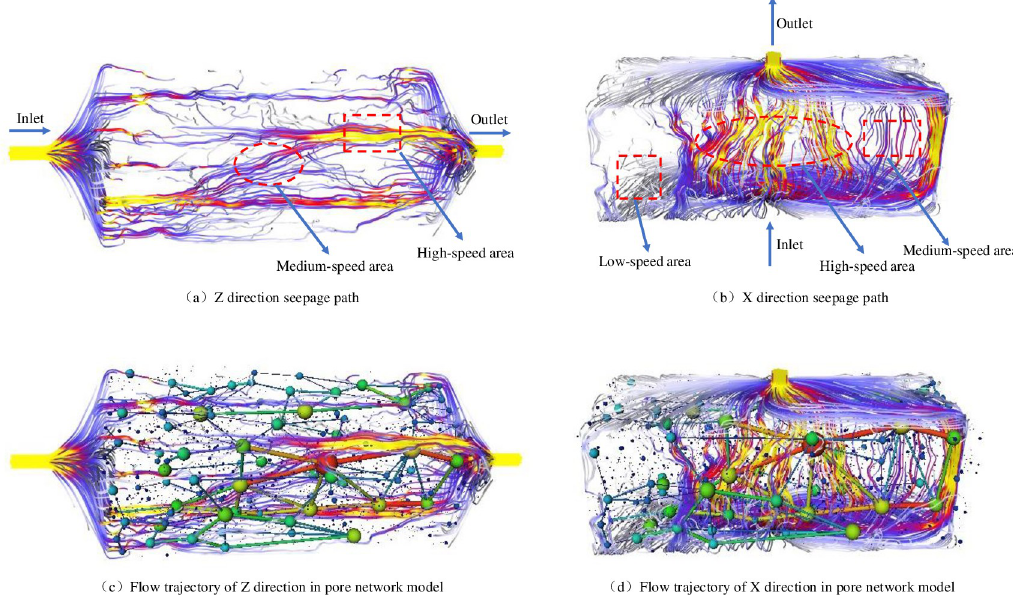
Fig 10. Flow trajectories in the x and z